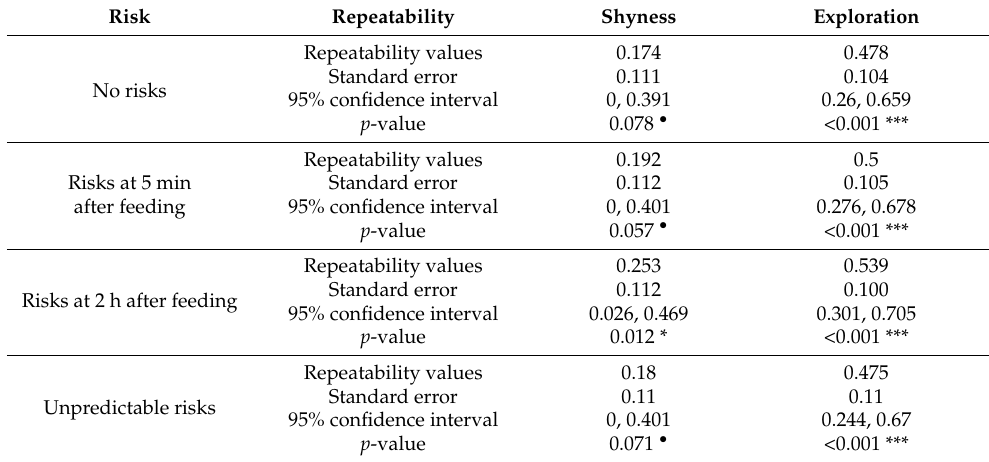
Table 1. The behavioral repeatability of female mosquitofish reared under different risk